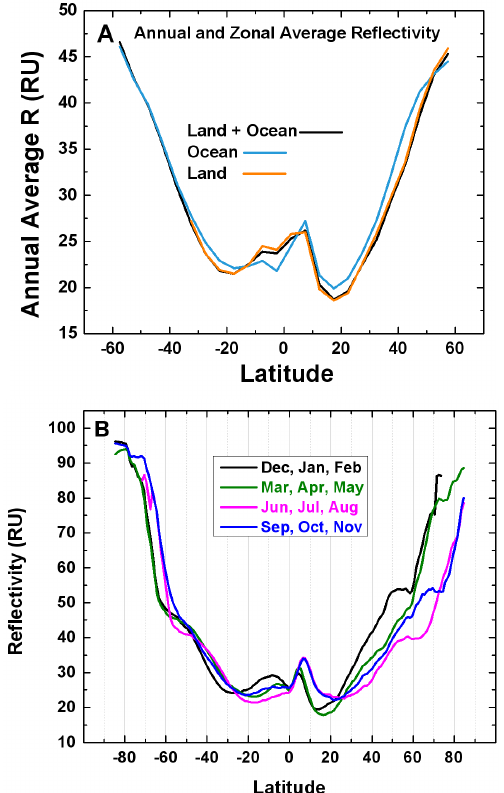
Fig. 5. (A) Thirty-three-year average of the noon-normalized zonal average time series as a function of latitude from the SBUV se- ries of instruments separated in to land only, ocean only, and com- bined. (B) Four-year seasonal average of OMI LER data (black: December–February; green: March–May; magenta: June–August; blue: September–November).